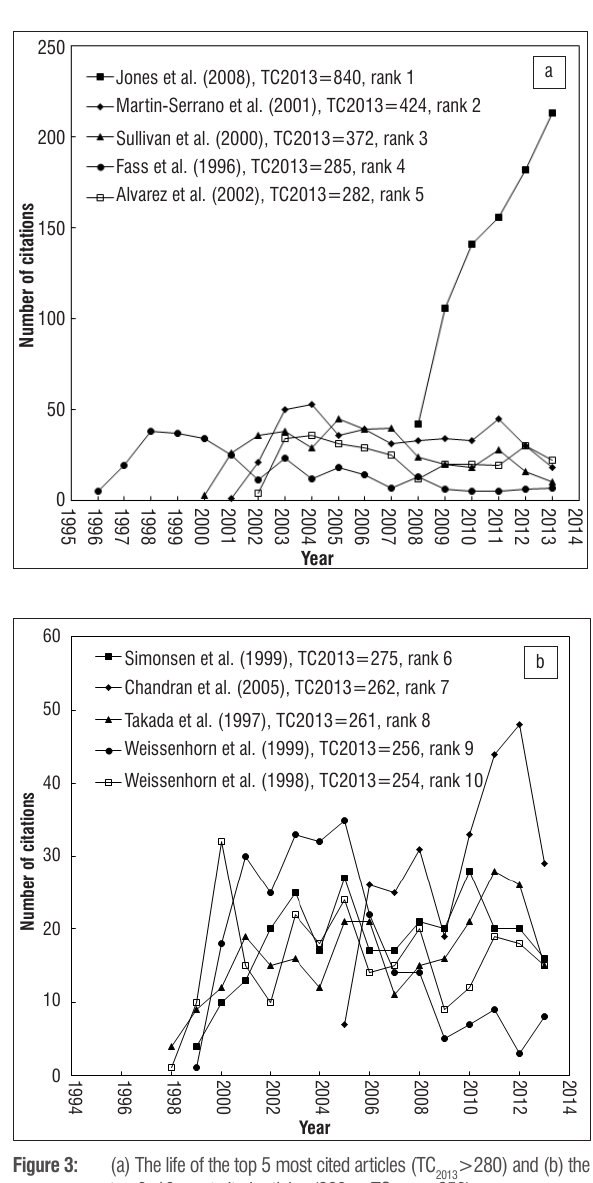
Figure 3: (a) The life of the top 5 most cited articles (TC top 6–10 most cited articles (280 > TC